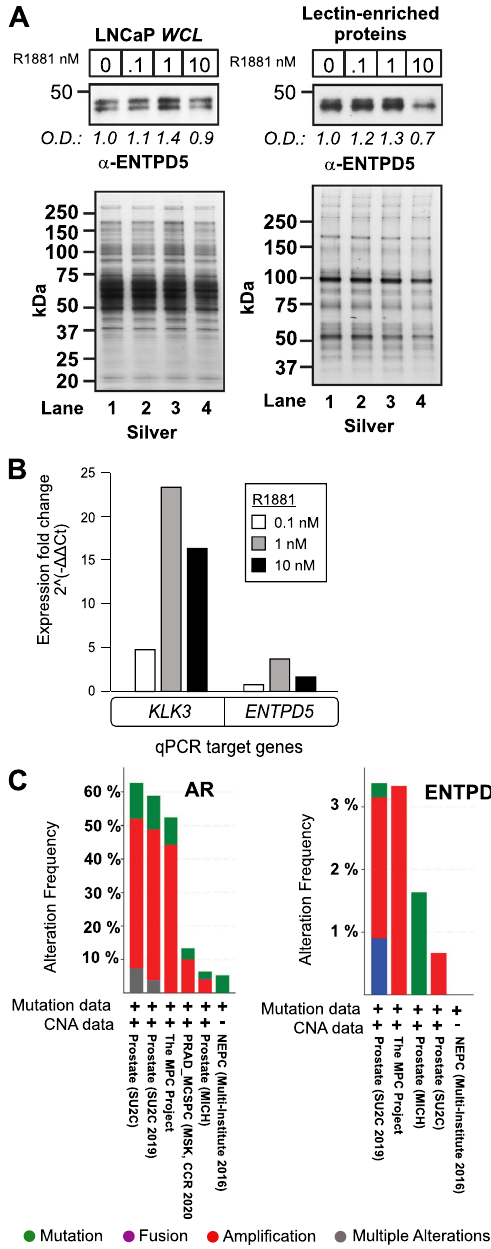
Figure 4. ENTPD5 expression is regulated by androgens in LNCaP cells. ( A ) (Upper panel) Dose-dependent ENTPD5 protein expression in androgen-treated LNCaP cells, in whole-cell lysates (WCLs) and lectin-enriched membrane protein extracts, as assessed by western blotting. (Lower panel) Silver-staining to verify equivalent protein loading for WCL and lectin-enriched protein samples. Western blot signals were normalized to the silver staining and quantified using the Image J software program 59 ( B ) ENTPD5 expression in androgen- treated LNCaP cells. KLK3 ( PSA) is a canonical androgen-regulated gene in androgen-responsive prostate tumor cells and served as a positive control. Mean and values and standard deviations were derived from three technical replicate wells (Results from a single biological experiment are shown; QPCR results from 2nd and 3rd independent biological experiments are shown in Supplemental Fig. 11). ( C ) OncoPrint genomic alterations of AR and ENTPD5 in advanced human prostate cancers. The three studies contained 325 samples obtained from 290